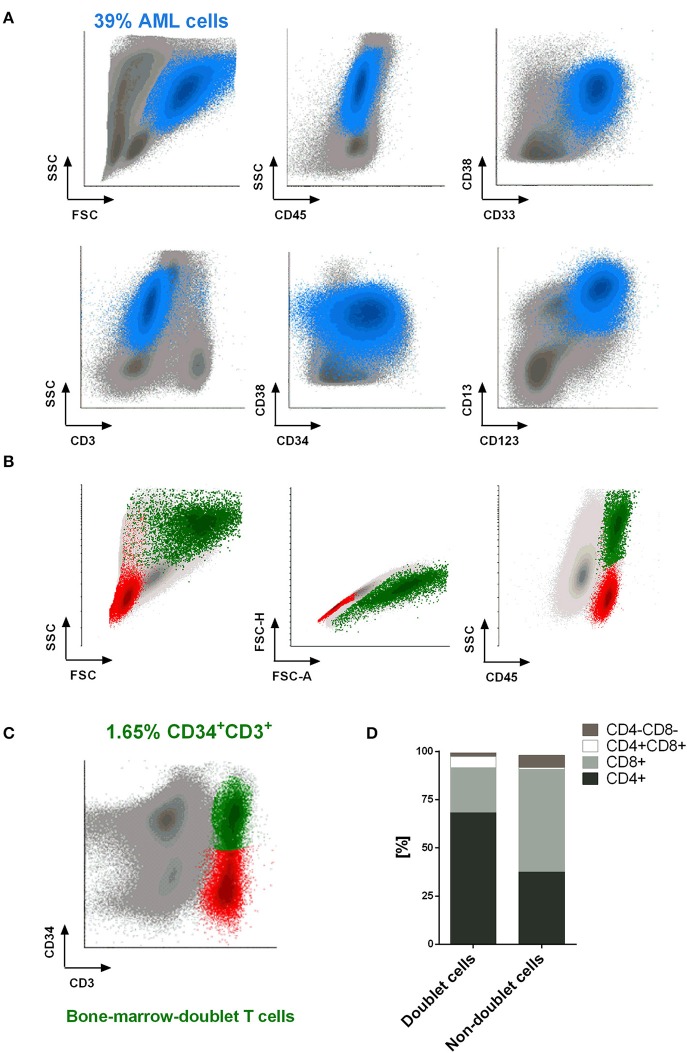
Doublet-forming T cells from bone marrow of AML patients. (A) Blast cells from bone marrow of an AML patient are shown. The immunophenotype of AML cells was: CD45low CD34+ CD117+ CD33+ CD38+ CD123+ CD13+/– (blue population). (B,C) T cells from bone marrow of an AML patient at diagnose were co-incubated with AML cells. Doublet-forming T cells were identified based on their FSC/SSC, doublet zone FSC-A/FSC-H distribution as well as their positivity for CD45 and both CD3 and CD34 (CD3+CD34+; green population). Non-doublet T cells were also identify as control (CD3+CD34–; red population); one representative case is shown. (D) Percentage of CD4+, CD8+, CD4+/CD8+, and CD4–/CD8– cells in bone marrow-doublet T cells compared to bone marrow-non-doublet T cells. Data show mean values of three independent experiments.